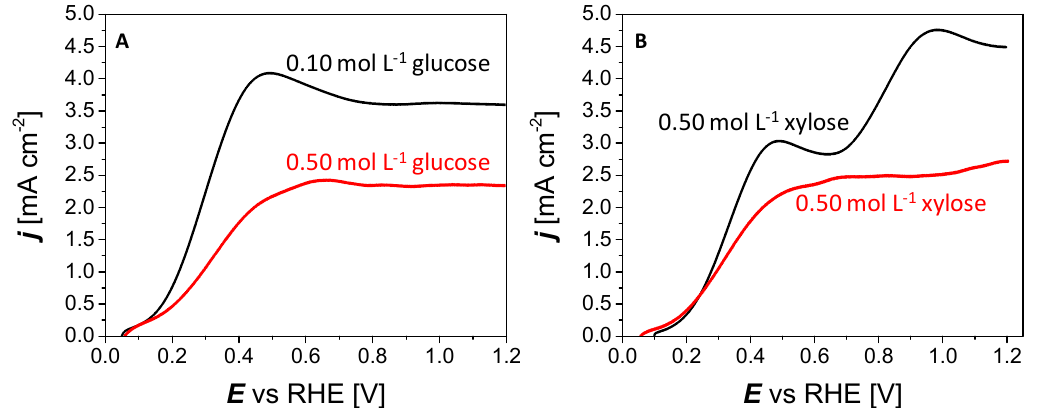
Figure 5. Third stable linear scan voltammetry curves recorded at Pd 3 Au 7 / C catalyst in 0.10 mol L − 1 NaOH medium in the presence of ( A ) 0.10 mol L − 1 and 0.50 mol L − 1 glucose and ( B ) 0.10 mol L − 1 and 0.50 mol L − 1 xylose.